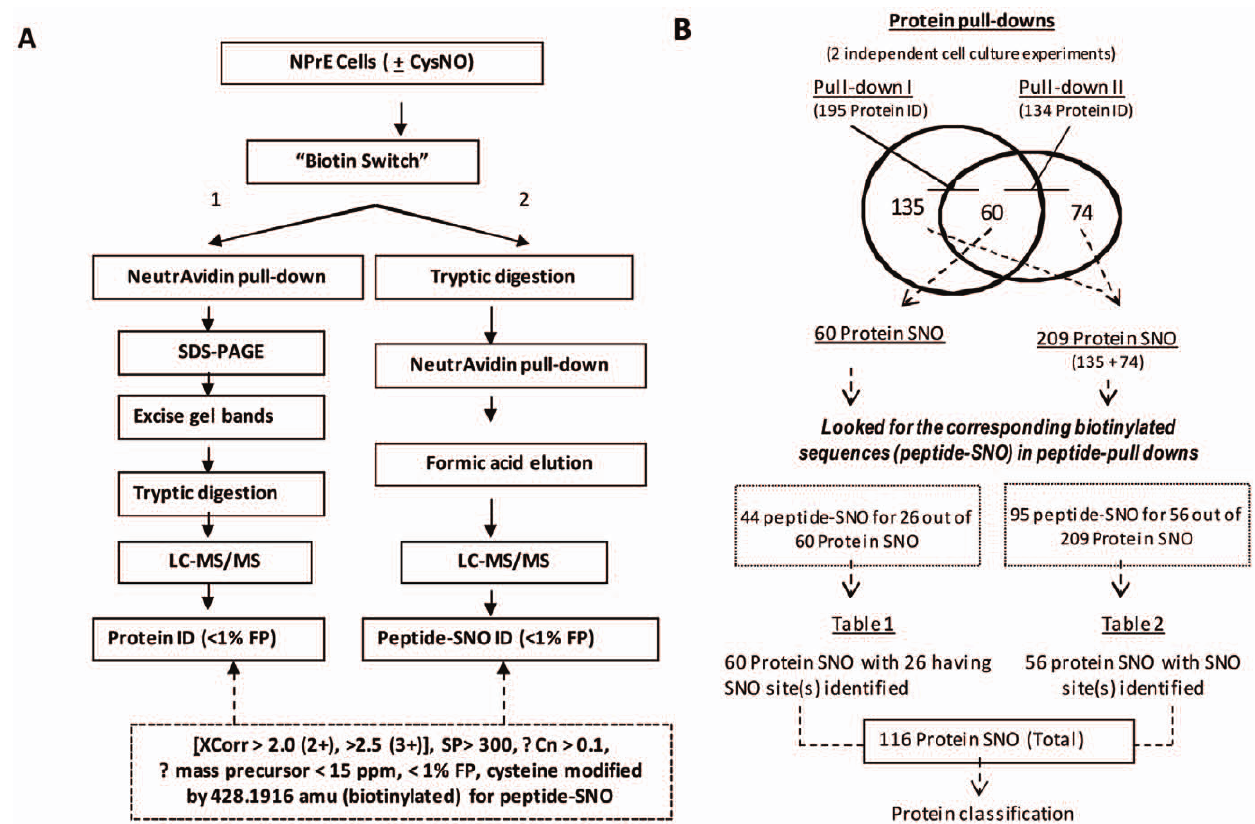
Figure 2. Identification of S- nitrosylated proteins. A) Schematic of the workflow. Approach 1 . Protein extracted from NPrEC treated with CysNO (1 mM) was subjected to a BST, and nitrosylated proteins were purified by Neutravidin pull-down, followed by SD S- PAGE. Nitrosylated proteins were identified by tryptic digestion and LC-MS/MS in the five gel bands (I–V) of lanes (CNTL, CNTL D NaAsc, CysNO, CysNO D NaAsc) according to the defined peptide selection criteria (XCorr 1.5, 2.0, 2.5, D Cn . 0.1, Sp . 300, precursor , 15 ppm, with , 1% FP). After the protein-SNOs were identified, their sites of modification in peptide (peptide SNO) were identified in approach 2: after biotin switching, 1 mg of protein was digested and the nitrosylated peptides were pulled down and subjected to mass spectrometric site mapping, according to the same peptide selection criteria. B ) Number of protein-SNO and peptide-SNO identification: Protein pull-downs from two independent experiments were performed to identify protein- SNOs, followed by the identification of the corresponding peptide-SNOs from peptide pull-downs. A total of 116 proteins were identified, with the sites of modification determined for 82.